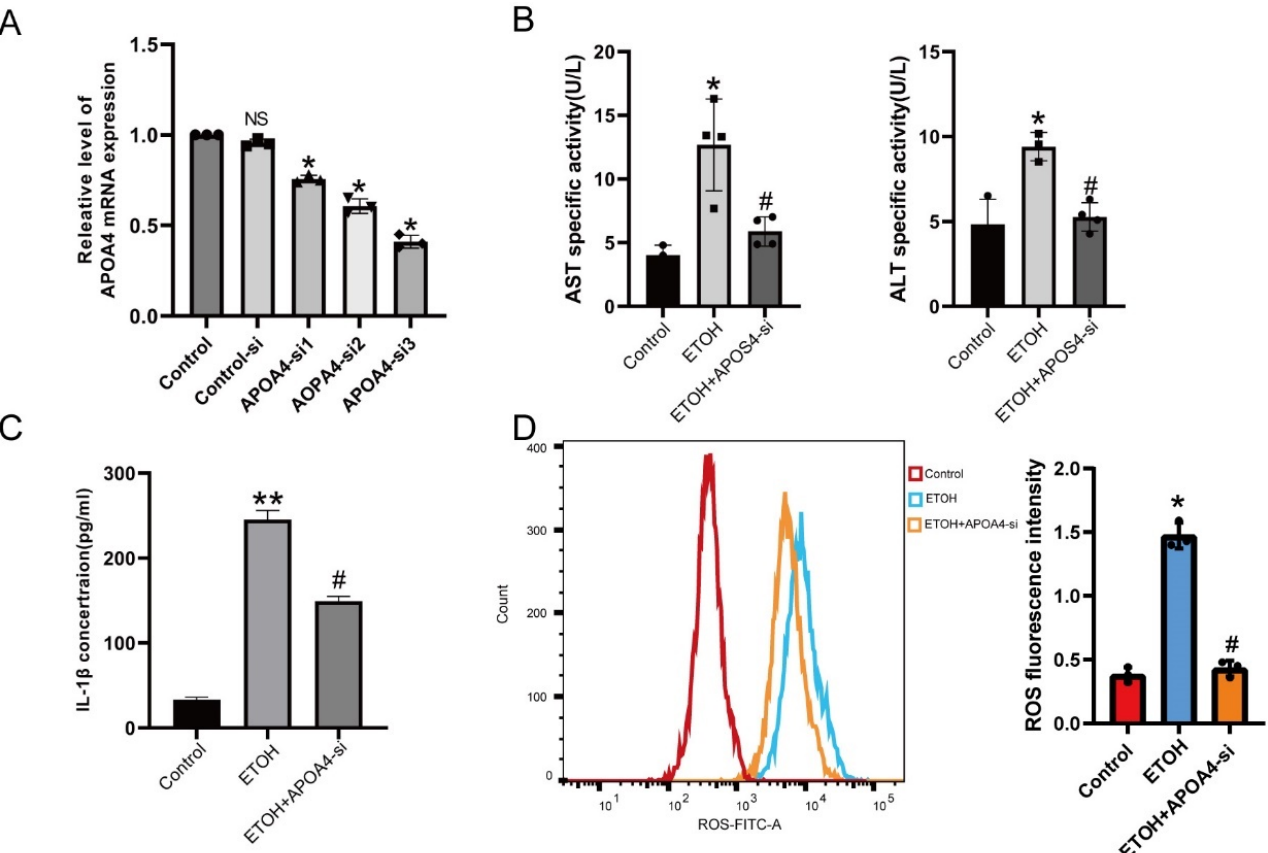
Figure 2. APOA4 inhibition decreased cell injury in ETOH -treated AML-12 cells. ( A ) AML-12 cells were transfected with APOA4 siRNA or control siRNA for 48 h. The expression of APOA4 was determined with qRT-PCR. ( B ) The AST and ALT activity in AML-12 cells after treatment with APOA4-si stimulated by ETOH or left untreated. ( C ) IL-1 β activity by IL-1 β ELISA kit. ( D ) ROS fluorescence intensity was detected by flow cytometry. ( n = 3–6) * p < 0.05, ** p < 0.01 vs. the control group; # p < 0.05 vs. the ETOH group or NS p > 0.05 vs. the Control group.